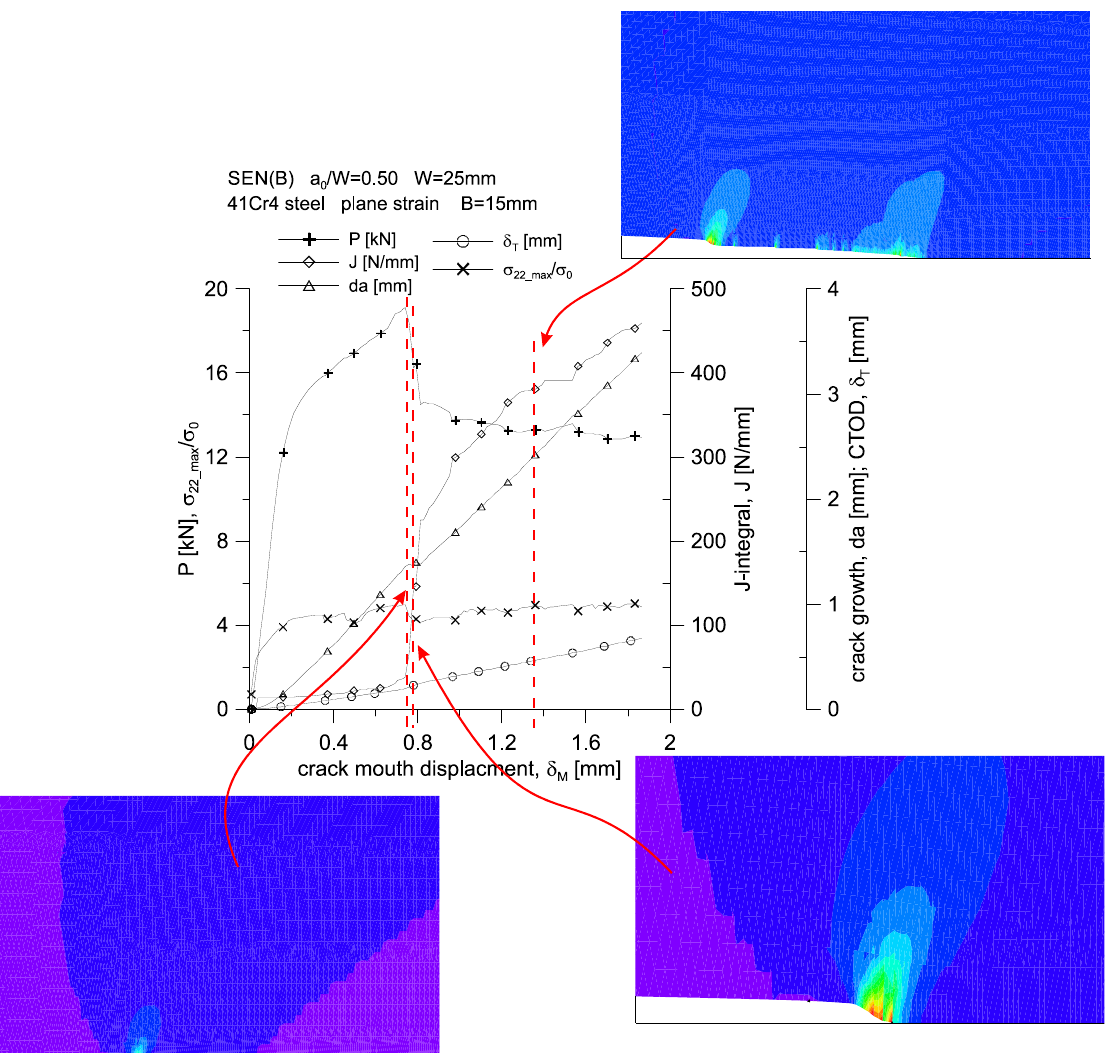
Figure 19. Changes of: the force, P, loading the specimen, the value of the J ‐ integral, the crack length increment, da, the crack tip opening displacement, δ T , and the maximum stresses opening the crack surfaces, σ 22_max / σ 0 , as a function of the crack mouth displacement, δ M , together with the distribution of accumulated plastic strains in close proximity to the crack tip. 41Cr4 steel specimen with a thickness of B = 15 mm.